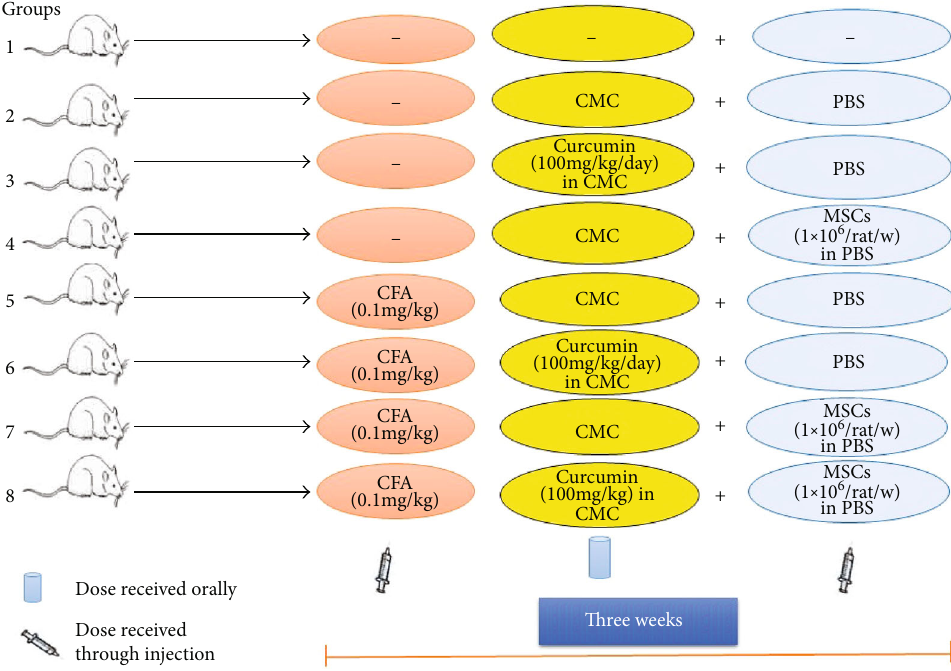
Figure 1: Experimental design and animal